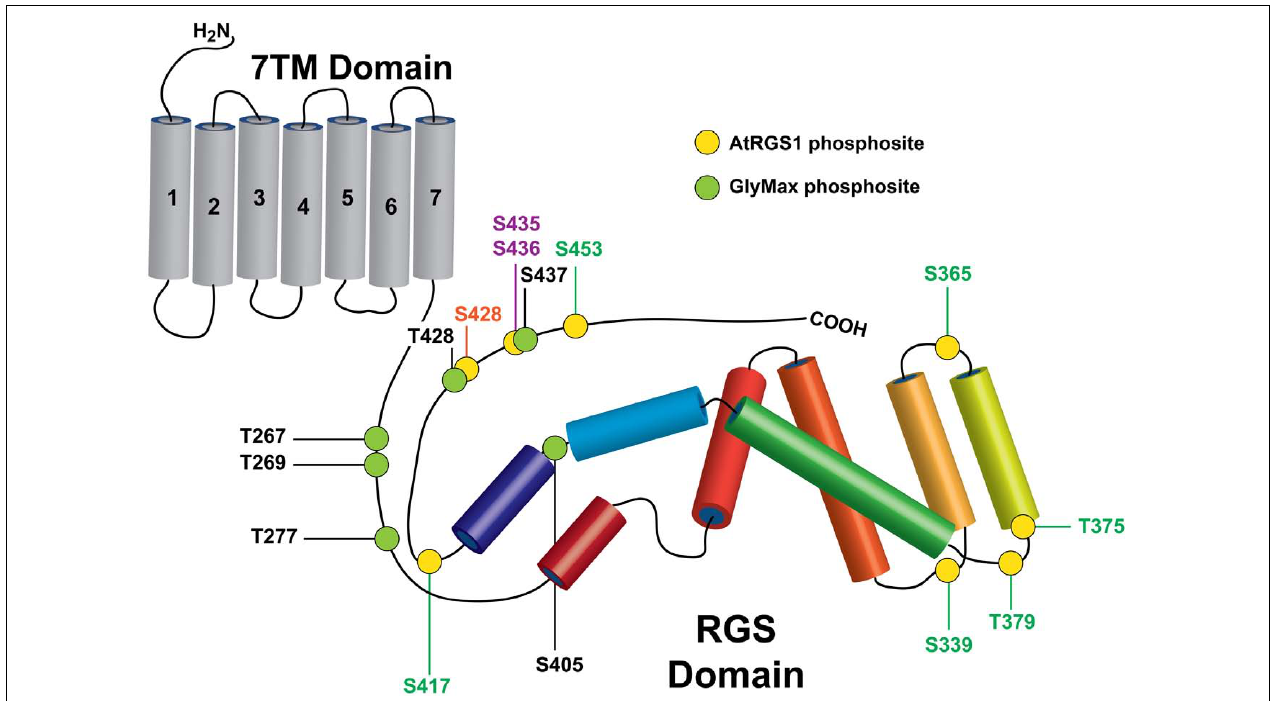
FIGURE 1 | Rreceptor-like kinase (RLK) targets on plant RGS proteins. Phosphorylation sites identified in this study on AtRGS1 and GmRGS2 as well as sites identified previously are illustrated in the context of the domain architectures of AtRGS1 and GmRGS2 (yellow and green circles). Kinases are indicated by site ID color: BRL3 (green), BAK1, PEPR1, and WNK8 (orange) and WNK8 only (purple) for both RGS proteins. NRF1 phosphorylation sites are indicated for GmRGS2 sites (black). Domain sizes are not to scale to emphasize RGS domain and surrounding